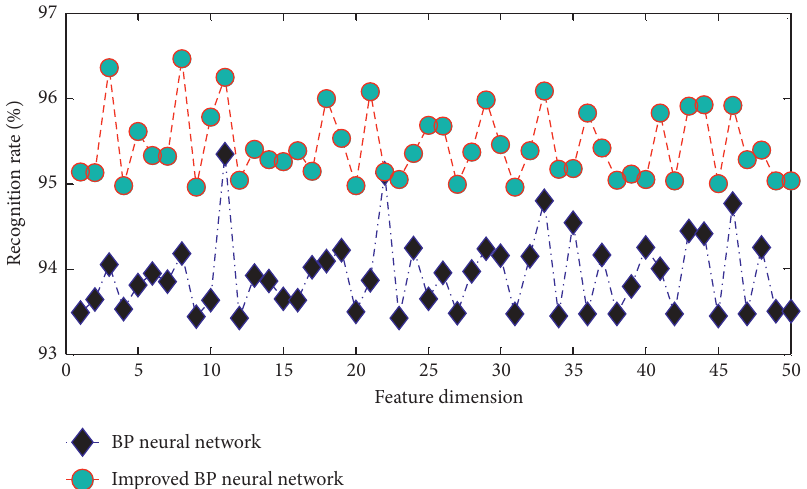
Figure 9: Comparison of the recognition effect of arbitrary 1000 test images.